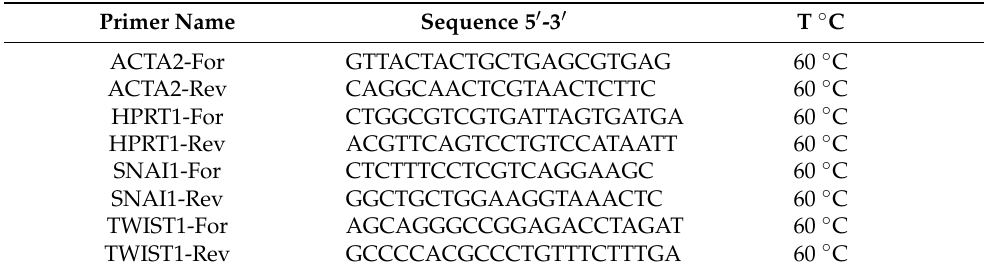
Table 3. Primers used in RT-qPCR